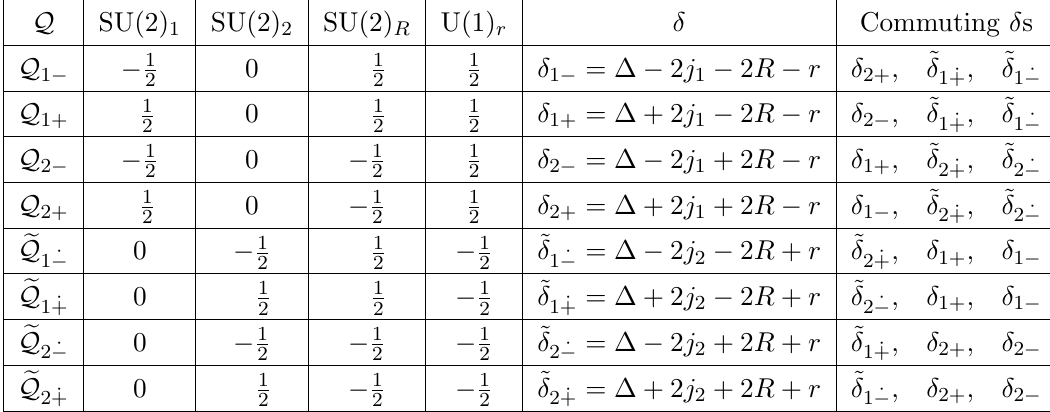
(cid:8) (cid:9) Q ; Q y , and